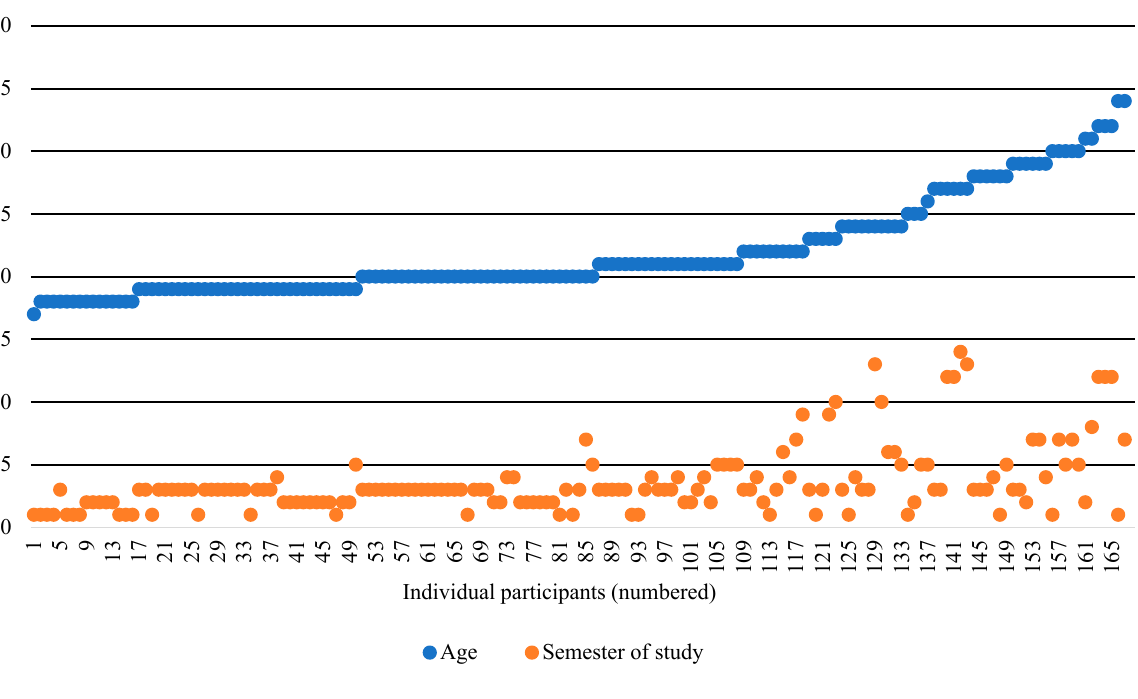
Figure 2. Course attendees’ distribution according to age and semester of study.